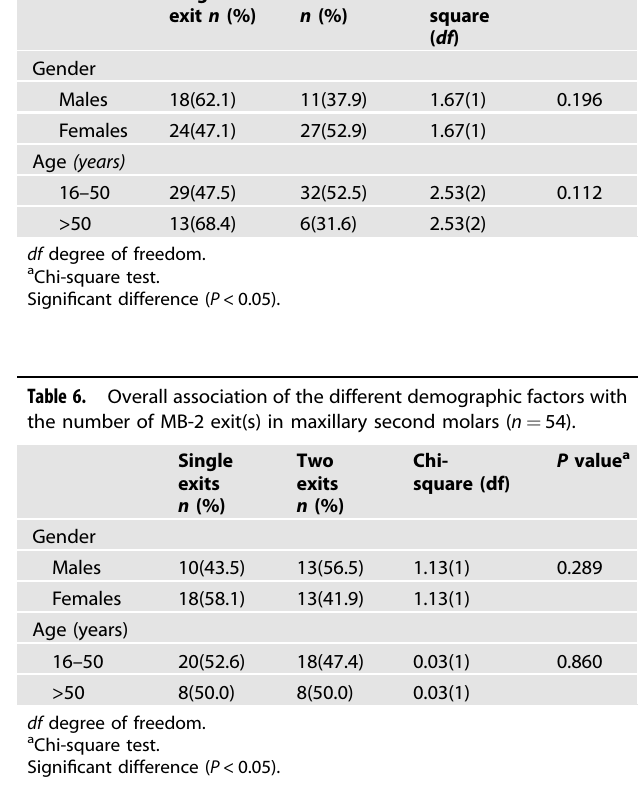
CI: 36.3, 58.9) (Table 4). The proportion of single apical foramen in MB-2 canals (51.9%) was also greater than two apical foramina (48.1%) in maxillary second molars. The associations of MB-2 exiting separate apical foramina were signi fi cantly greater in ages